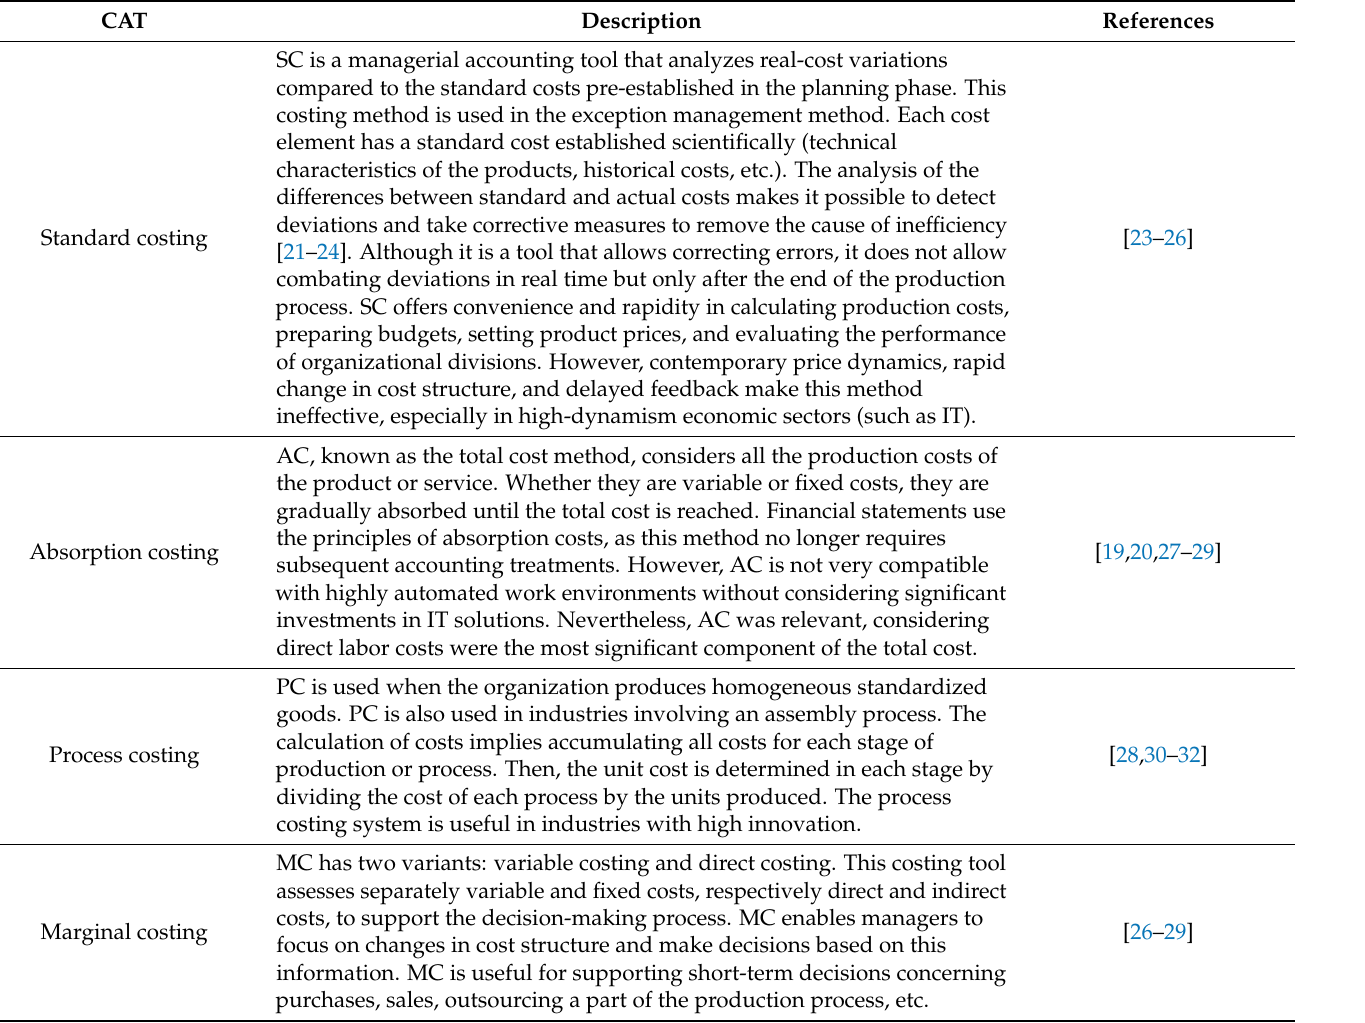
Table 1. Traditional cost accounting